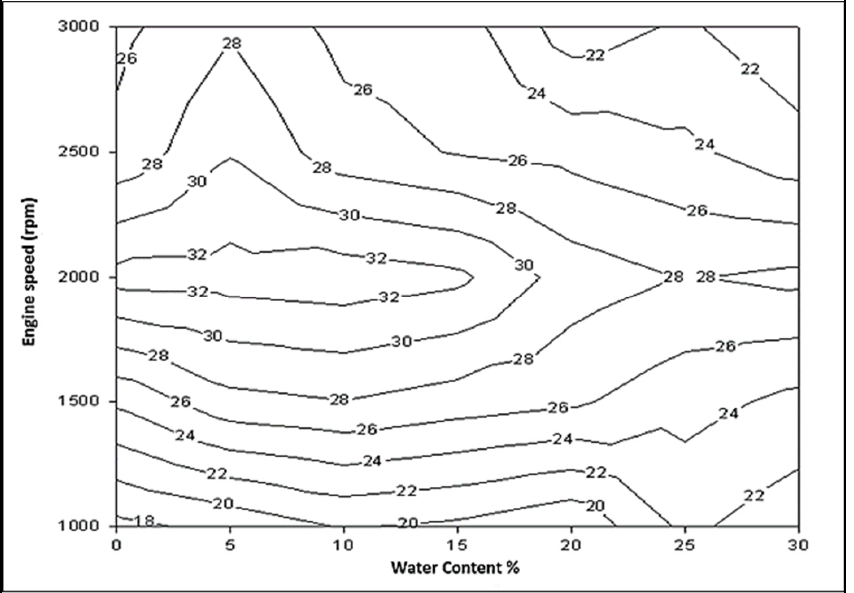
Figure 11. Brake thermal effeciency (%) for pure diesel and different water addition to diesel fuel.